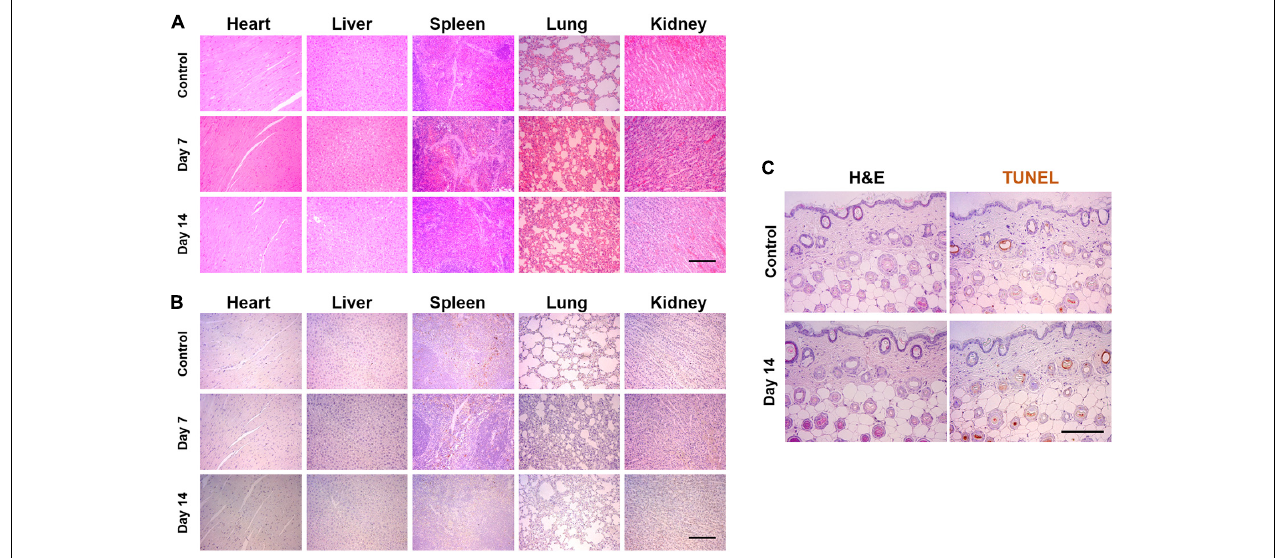
FIGURE 7 | Pathological analysis of SF via intraperitoneal injection and applying to the skin surface. The 50 µ l of SF was injected every other day until 2 weeks or applied to the dorsal skin surface of mice. (A) Hematoxyline and eosin (H&E) and (B) TUNEL staining of the tissues harvested from the heart, the liver, the spleen, the lung, and the kidney. (C) H&E- and TUNEL-stained images of the skin, which did not display any toxical responses (Scale bar = 200 µ m).